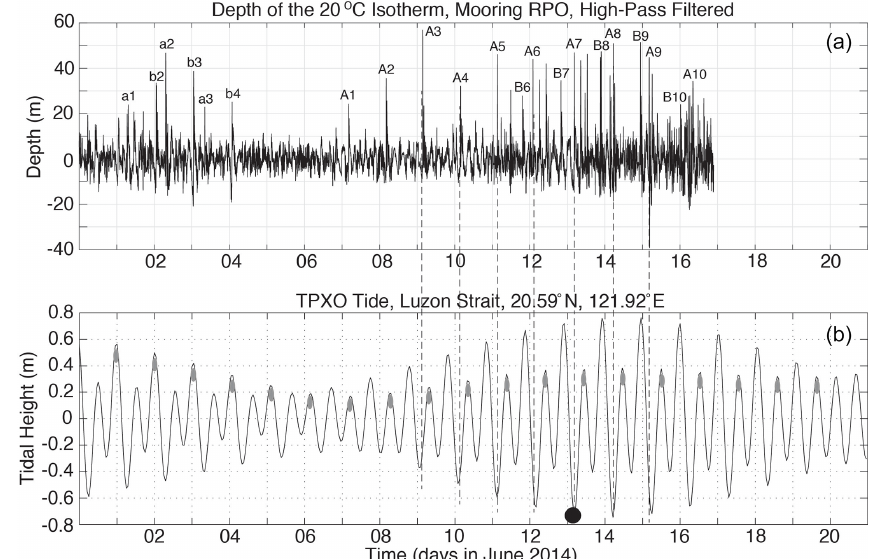
Figure 3. (a) Time series showing the depth of the 20 ◦ C isotherm observed by mooring RPO located at the 266m isobath (Fig. 1). The time series was high-pass-filtered to separate thermal displacements due to NLIWs from the internal tides and mean (mesoscale and seasonal) flows. The sharp depressions of the isotherm indicate passing NLIWs. The type-a and type-b waves are labeled using lowercase for the first fortnight and upper case for the second. (b) Barotropic tidal amplitude in the central Luzon Strait from the TPXO global tidal model (Egbert and Erofeeva, 2002), at a point located between Batan and Itbayat Island in the Luzon Strait. The gray ellipses indicate how the major and minor tidal beats switched positions during the neap tide. The black circle indicates the time of the full moon on 13 June. The waves (a) have been lagged by the propagation time from the strait (48.5h) to better align with the barotropic tidal envelope in the generating region. The vertical dashed lines show how the lagged a waves aligned with the ebb tide in the